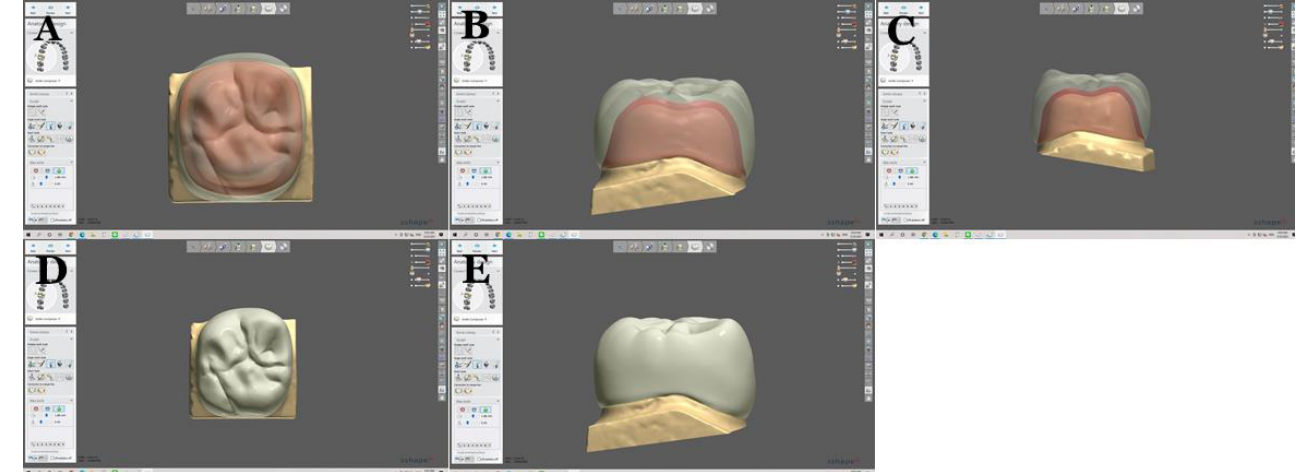
Figure 1. Crown designed digitally using 3Shape software (TRIOS ® ). Crown from different views ( A – E ). Table 1. Summary of the crown materials used in this